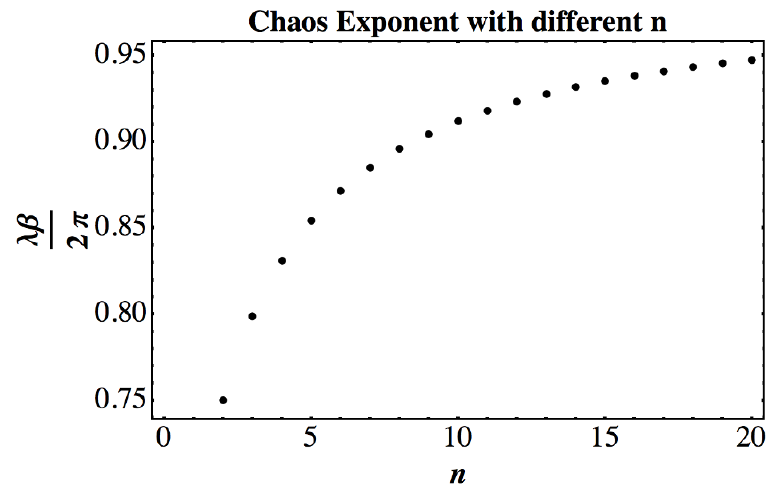
Figure 4 . The (cid:12)gure shows the Lyapunov exponent for the scaling model with di(cid:11)erent values of n . The rescaled Lyapunov exponent approaches the chaos bound as n